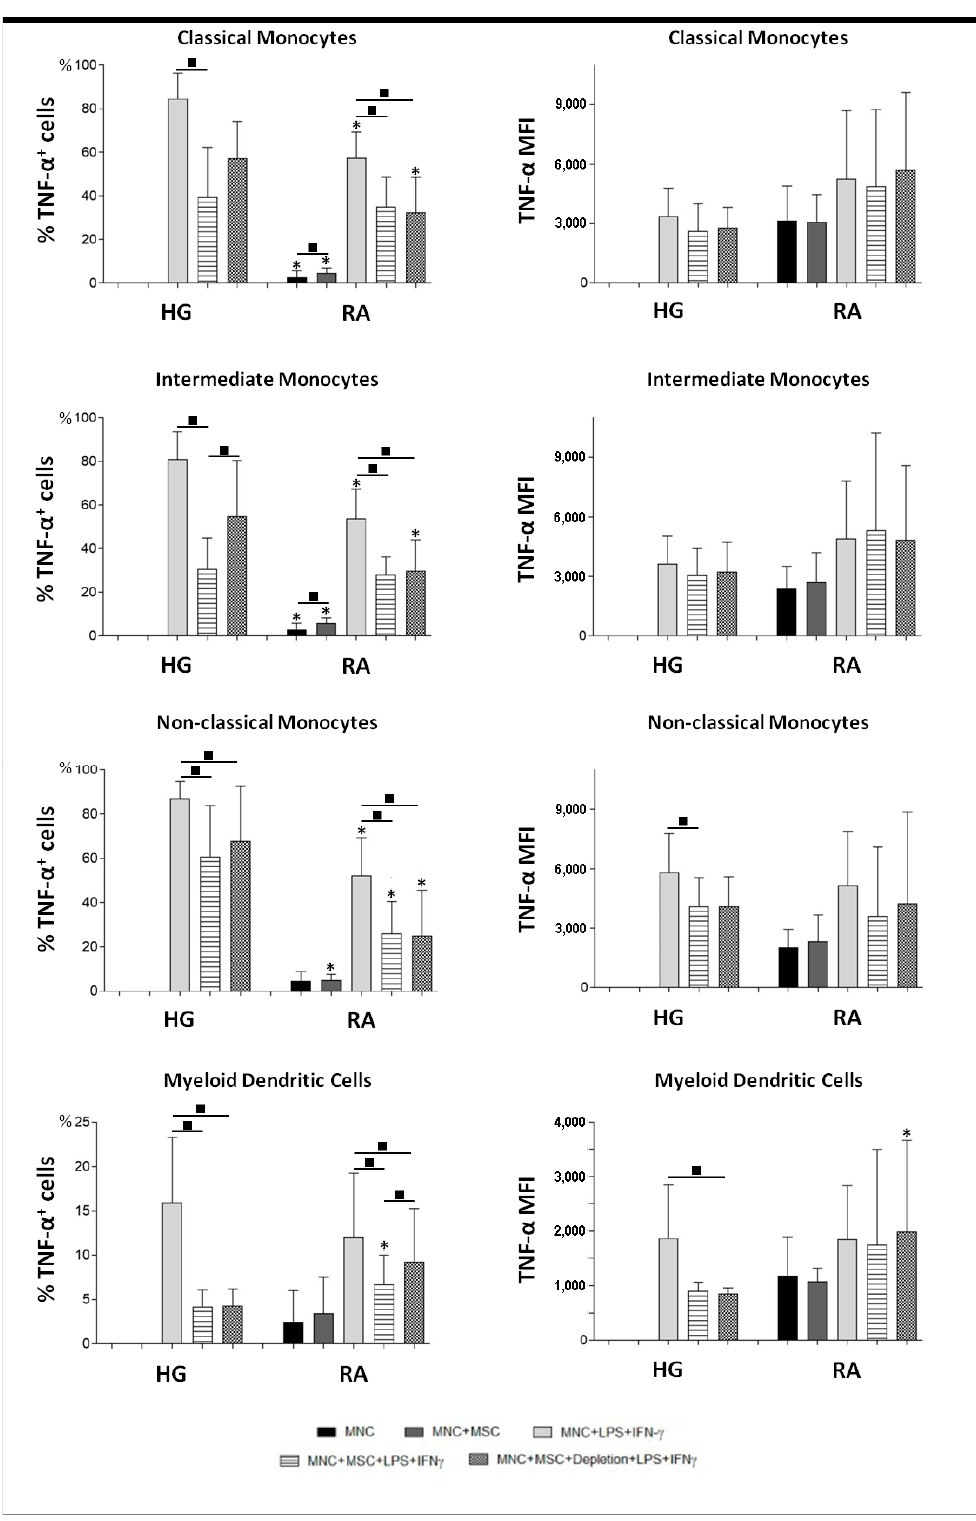
Figure 3. TNF- α protein levels in monocytes and mDCs from RA patients and healthy individuals. Percentage (mean ± standard deviation) of cells producing TNF- α , among monocyte subpopulations (classical, intermediate and non-classical) and mDCs, ; amount of protein (MFI) produced per cell (mean ± standard deviation), measured in the following experimental conditions: unstimulated PBMCs (MNC), non-stimulated PBMCs in co-culture with MSCs (MNC + MSC), PBMCs stimulated with LPS plus IFN γ (MNC + LPS + IFN γ ), PBMCs in co-culture with MSCs and stimulated with LPS plus IFN γ in the presence of MSCs (MNC + MSC + LPS + IFN γ ), PBMCs in co-culture with MSCs